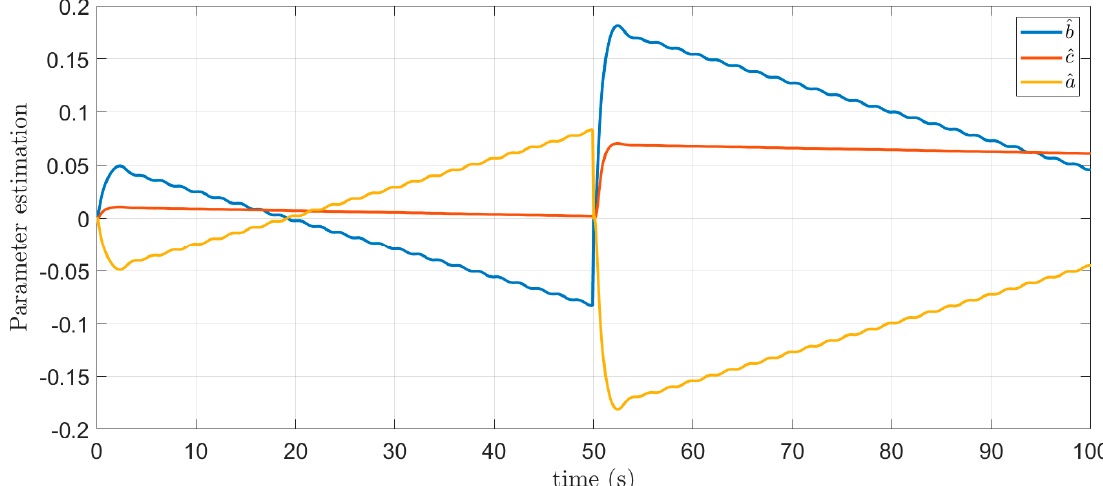
Figure 10. Simulation result of the control input of the direct adaptive control without robust action.